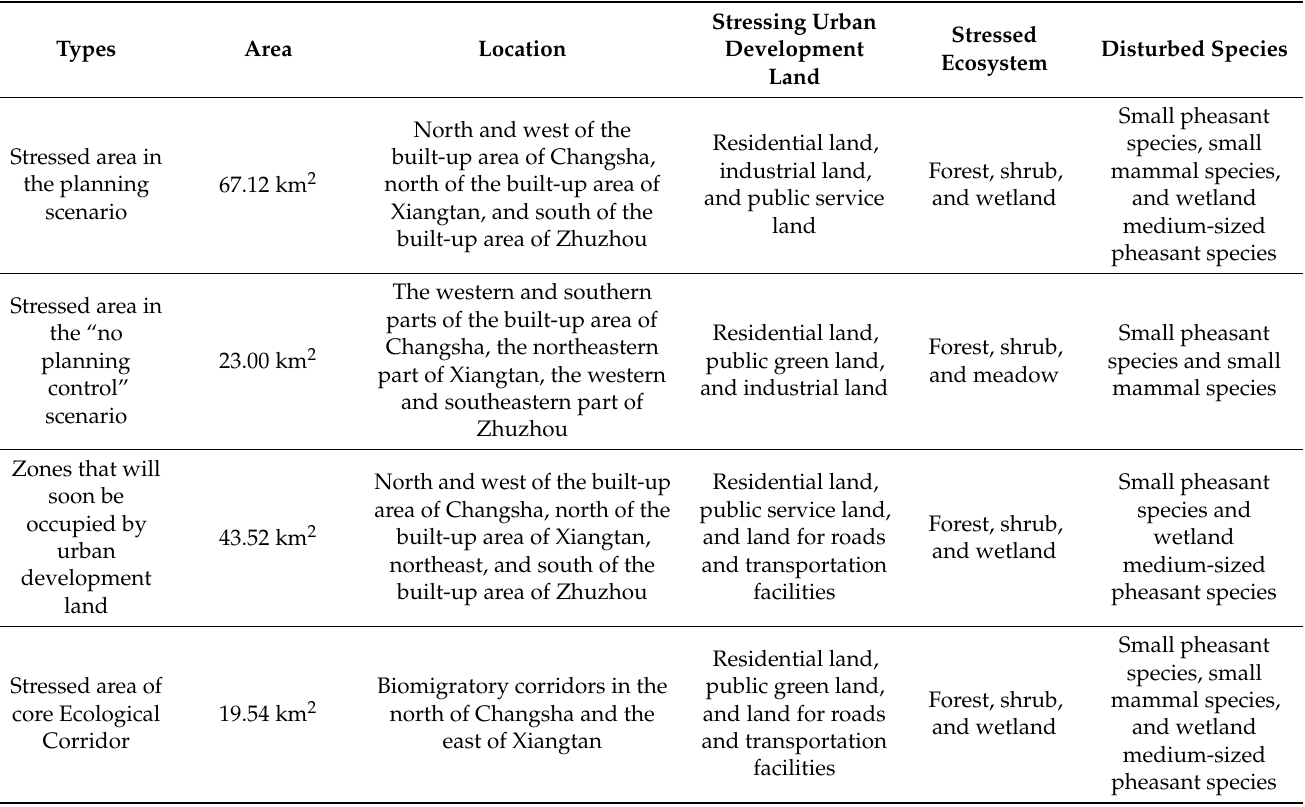
Table 7. Identification of key green infrastructure control